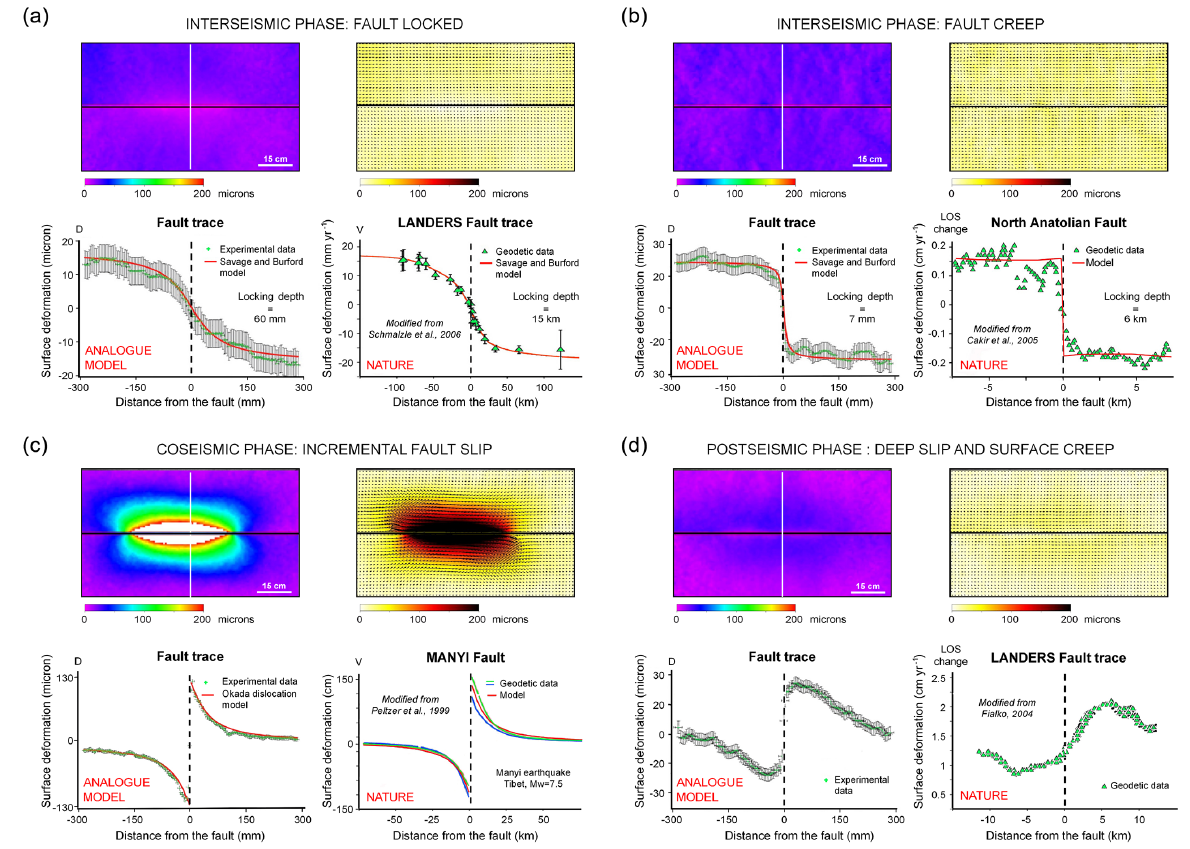
Figure 15. Seismic-cycle deformation as shown by multi-layer strike-slip fault models by Caniven et al. (2015): (a, b) inter-seismic (locked and creeping fault, respectively); (b) coseismic; (c) post-seismic phase (modified from Caniven et al.,